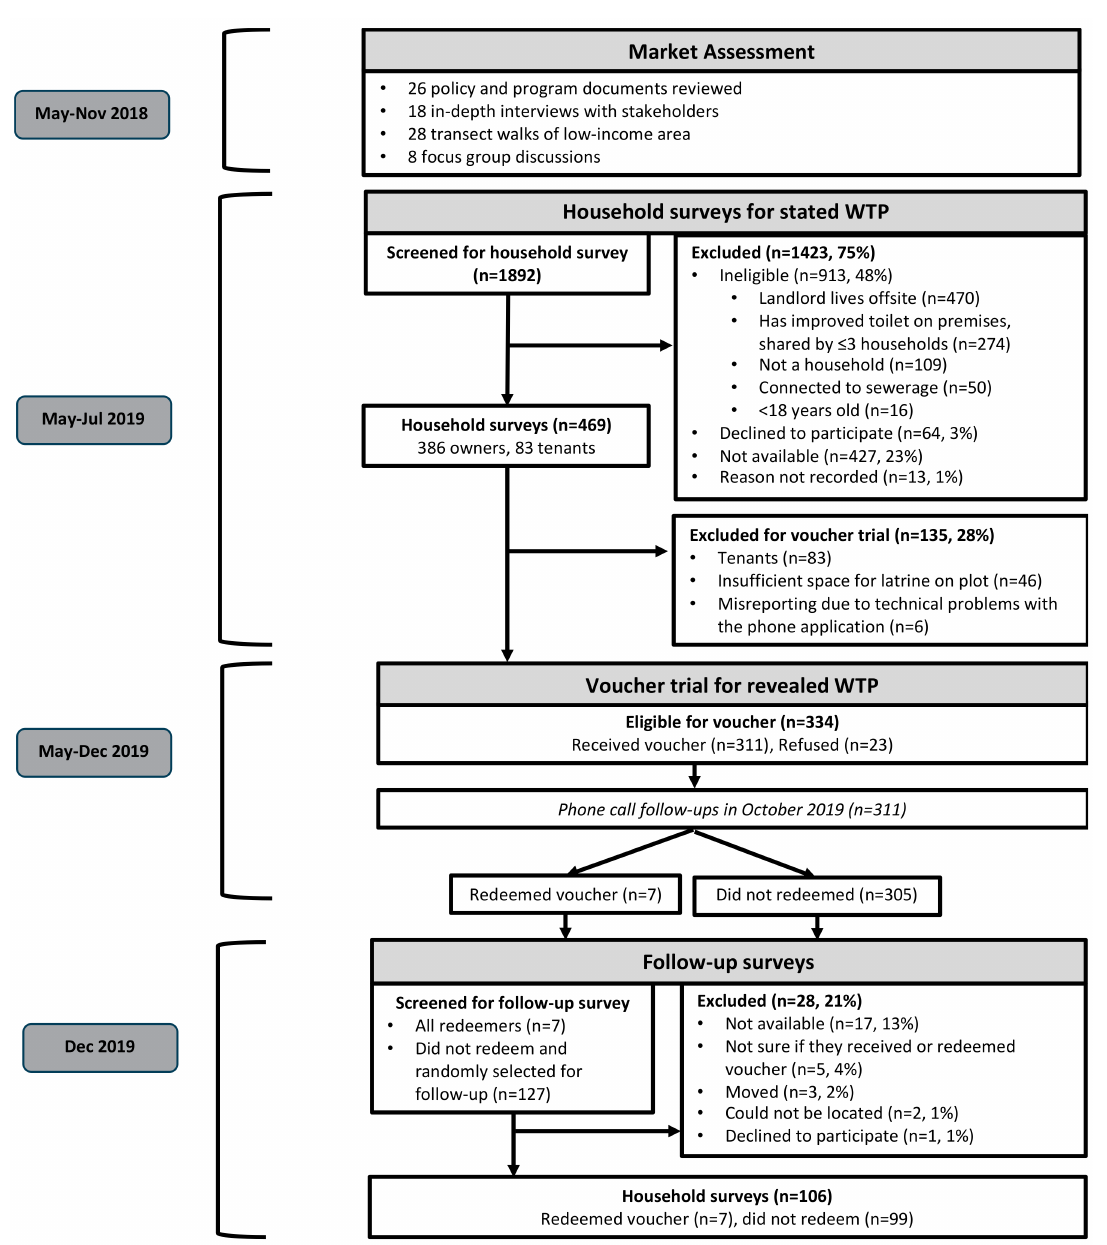
Figure 1. Study flow